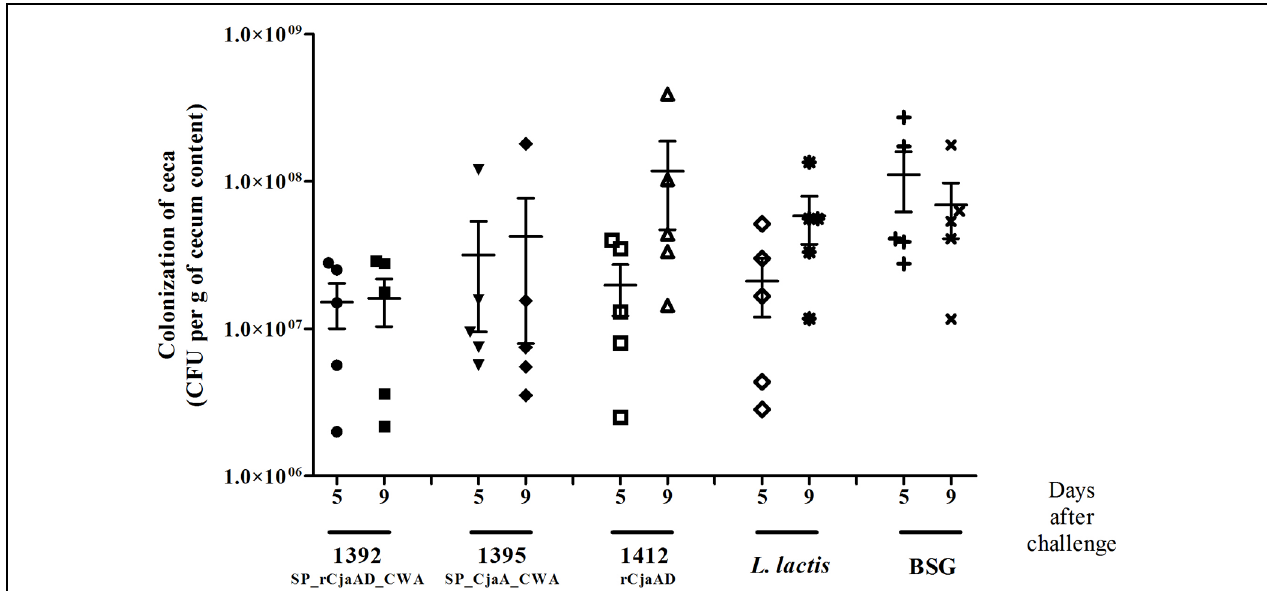
FIGURE 8 | Colonization of chickens vaccinated with L. lactis strains ( L. lactis /pUWM1392, L. lactis /pUWM1395 and L. lactis /pUWM1412) and then given a C. jejuni challenge. Chickens were given three doses of the vaccine strains at 1, 8, and 17 days after hatch and challenged with C. jejuni 12/2/pUOA13 5 days later. Control birds were given BSG. Viable C. jejuni cells were recovered from the ceca of chickens at specified days after challenge. Bacterial recoveries represent colonization levels of 5 birds per time interval. The geometric mean for each group is denoted by bars. No significant differences ( p < 0.05) between groups were